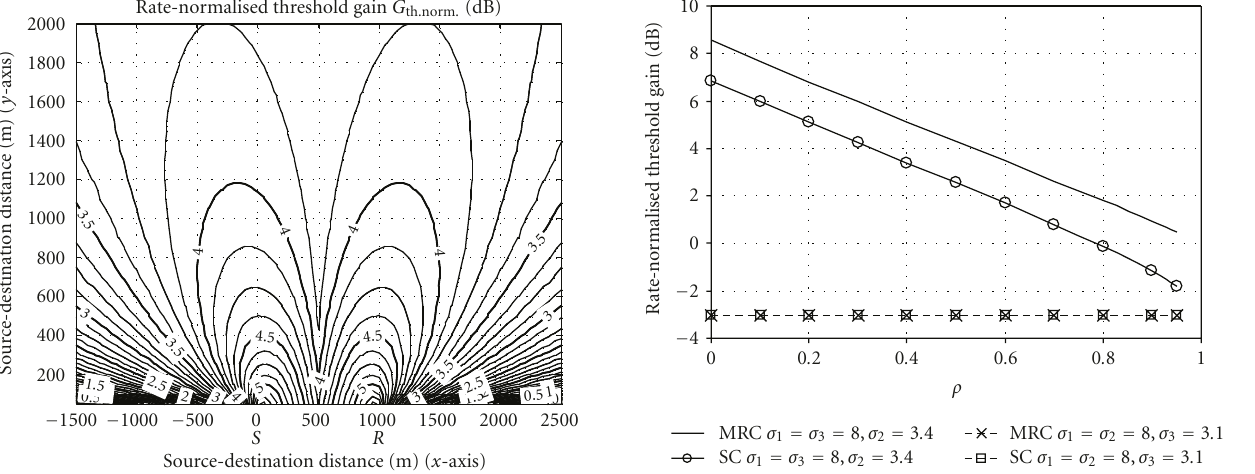
Figure 3: Variation of SNR gain with destination position for MRC cooperative diversity system deploying protocol A.